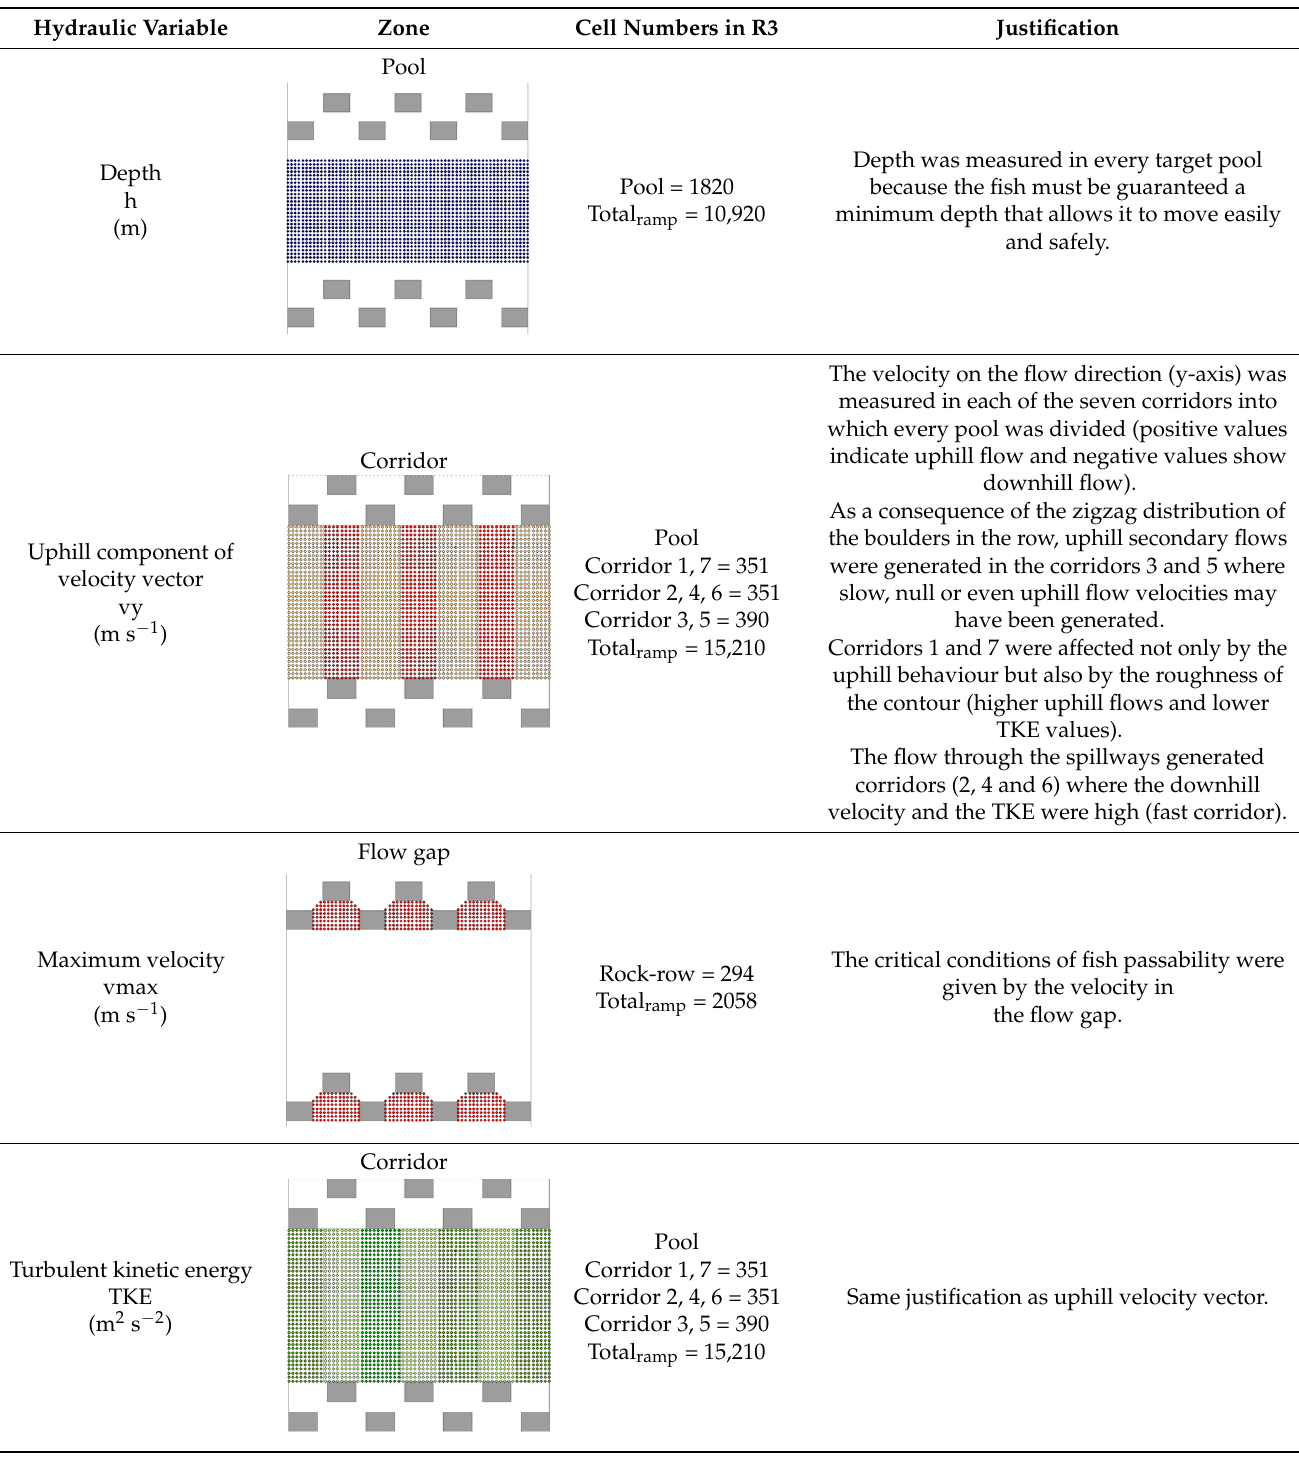
Table 2. Primary details of the zones where the hydraulic variables were taken.